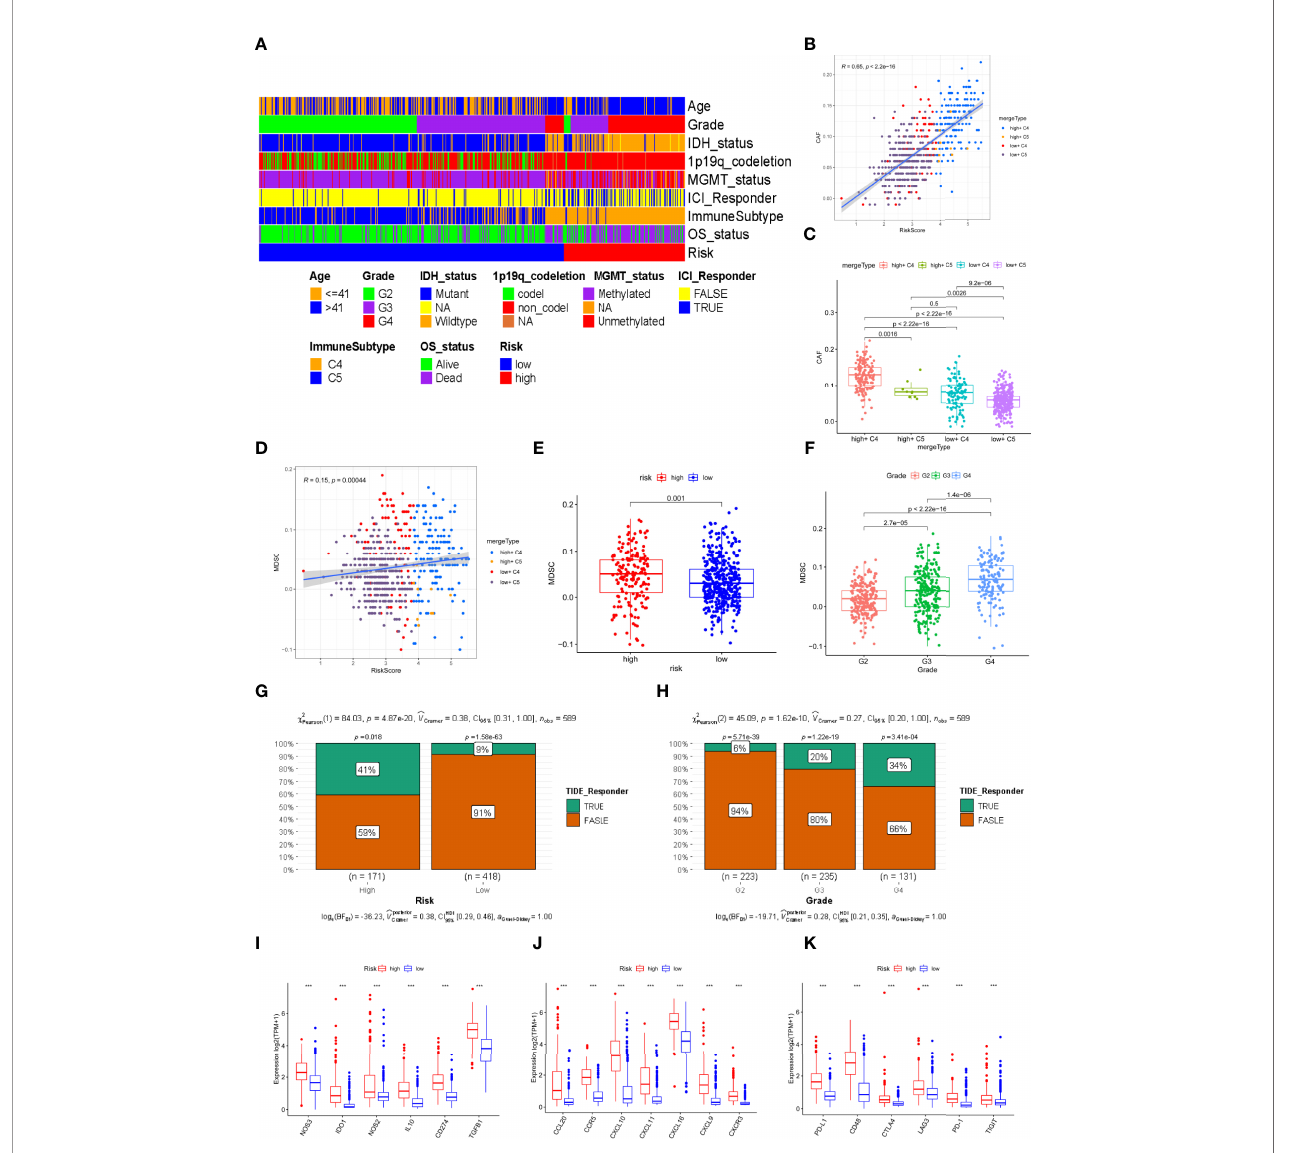
FIGURE 6 | Prediction of immune therapy and the correlation of immunosuppressive cell with risk signature in the TCGA cohort. (A) The distribution of multiple clinical characteristics, immune subtypes, and survival status in the high- and low-risk groupings. (B, D) The correlation of the risk score with CAFs and MDSCs. (C) The difference of in fi ltration fraction of CAFs in the different subtypes. (E, F) The in fi ltration fractions of MDSCs in the different risk groups and tumor grades. (G, H) Distribution of the predicted responsiveness of glioma patients for the ICI therapy in the different risk groups and tumor grades by the TIDE database. (I – K) The different expression levels of immunosuppressive cytokines, tumor-associated chemokines, and immune checkpoints related genes (*** represent p <